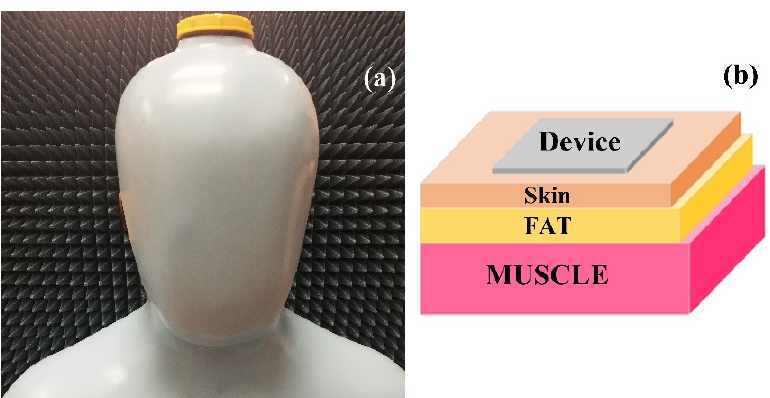
Figure 4. ( a ) A real image of the human torso phantom model; ( b ) A 3D view of a layered numerical representation of human tissue.